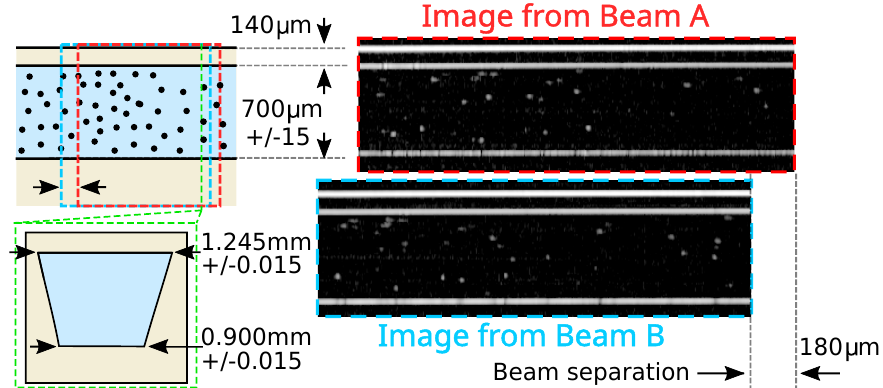
Figure 2. Schematic of the straight channel section of the microfluidic chip with the area imaged by Beams A and B of the dual beam OCT instrument marked and images from the dual beam OCT instrument with the appropriate beam separation. A cross-section of the microfluidic channel is shown in the lower